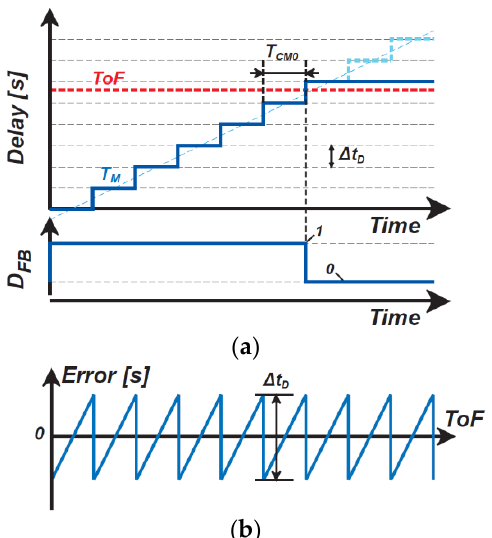
Figure 2. An equivalent block diagram for coarse time-of-flight (ToF) measurements.